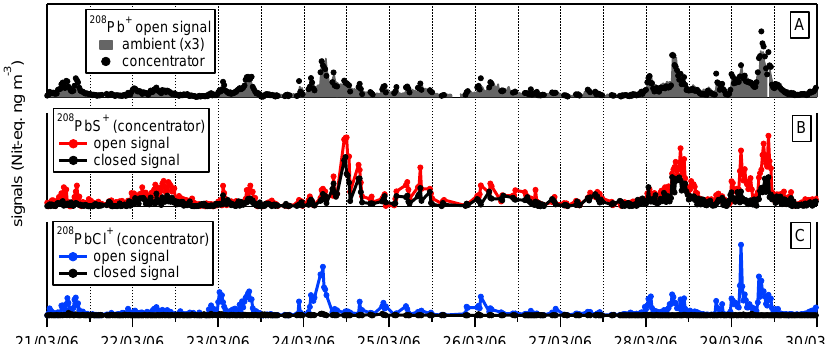
Fig. 10. Panel (A) : Time series of 208 Pb + ambient and concentrator open signals. Note that ambient signal has been multiplied by 3. Panels (B) and (C) : Time series of concentrator 208 PbS + and 208 PbCl + , respectively, open and closed ions signals. All data collected at T0.